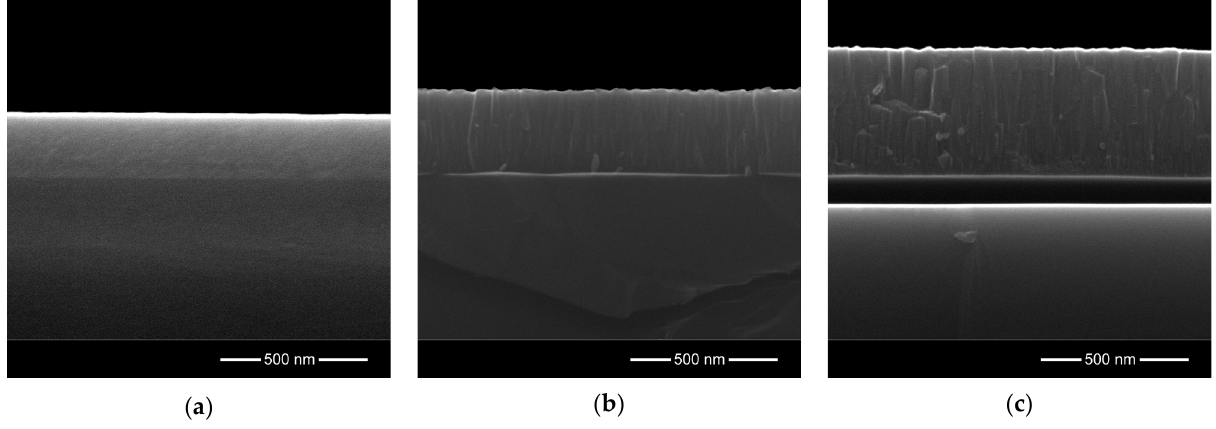
Figure 8. Cross-sectional view of the deposited layer when using the DC power supply and for the deposition times of ( a ) 5 min, ( b ) 10 min, and ( c ) 15 min. Similarly, the corresponding images for thickness measurements of the deposited film for the case of HiPIMS power supply are represented in Figure 9. The same magnification factor was used in all displayed SEM investigations to aid the visual perception.